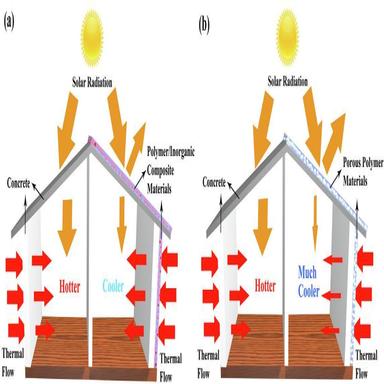
Schematic diagram of buildings with and without passive cooling materials: (a) Polymer/inorganic composite materials; (b) Porous polymer materials.